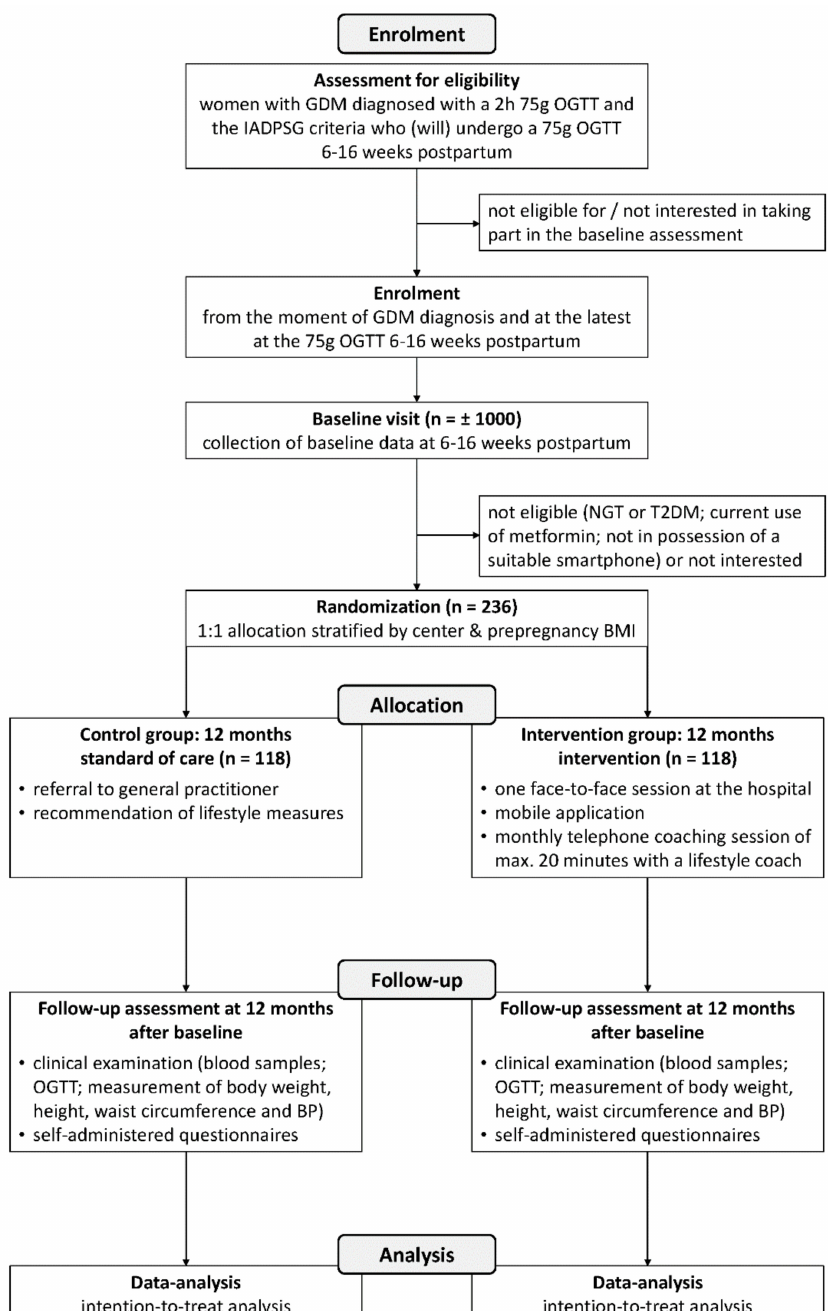
Figure 1. ‘Standard Protocol Items: Recommendations for Interventional Trials’ (SPIRIT) flow diagram showing the flow of participants through the phases of the Mobile-based lifestyle intervention in women with glucose intolerance after gestational diabetes mellitus (MELINDA) randomized controlled trial. GDM: gestational diabetes mellitus; OGTT: oral glucose tolerance test; IADPSG: The International Association of Diabetes and Pregnancy Study Groups; NGT: normal glucose tolerance; T2DM: type 2 diabetes mellitus; BMI: Body Mass Index; BP: blood